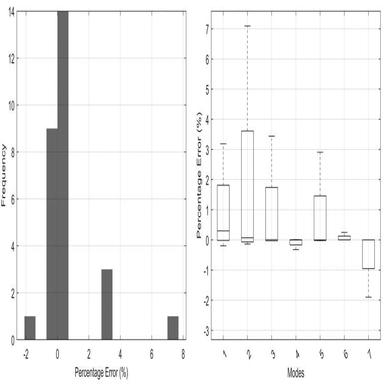
YUKI-Deep-ANN frequency prediction errors.